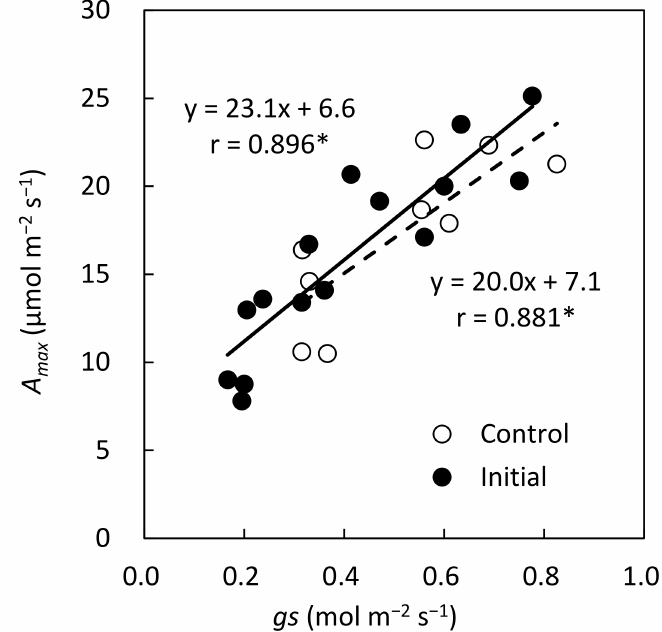
Figure 4. Relationship between maximum photosynthesis rate ( A max ) and stomatal conductance ( gs ) on the control ( ) and initial fertilization treatment ( • ). Significant correlation ( p < 0.05) is indicated (cid:35) with *.